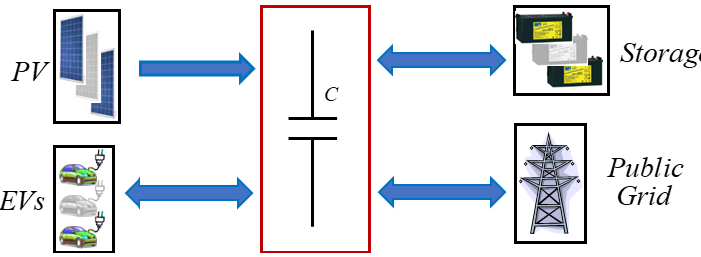
Figure 1. DC microgrid with integrated vehicle-to-grid (V2G). PV: photovoltaic sources, EV: electric vehicles.